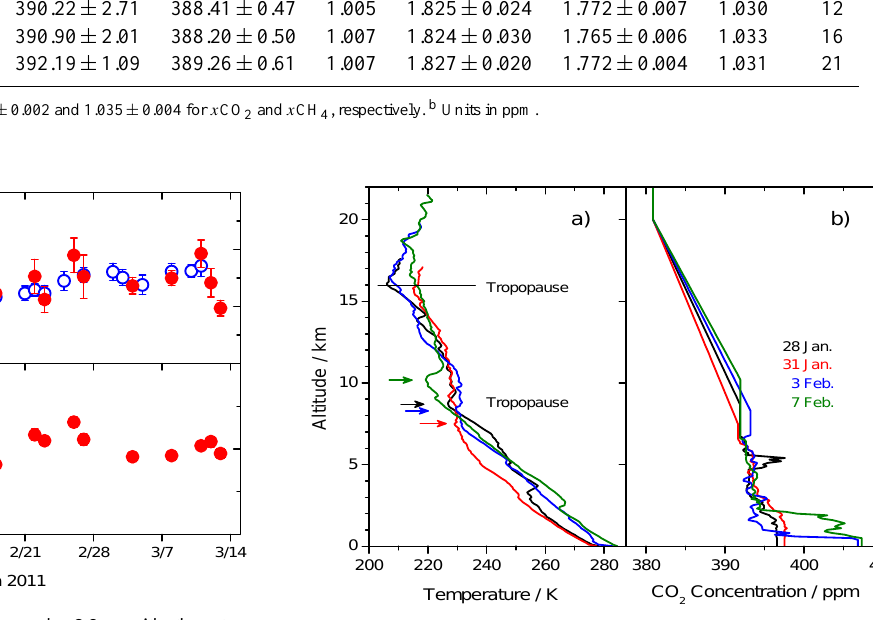
on 31 January and − 0.51 ppm on 8 March, respectively. The average x CO 2 from the OSA at UoW during 31 January– 13 March was 387.23 ± 1.57 ppm, being lower than that at JAXA in Tsukuba by 5.5 ppm. The vertical profiles of temperature over Tsukuba mea- sured by the sondes are shown in Fig. 7a where the first tropopauses lie at 8.7, 7.5, 8.3 and 10.2 km on 28 January (black), 31 January (red), 3 February (blue) and 7 Febru- ary (olive), respectively, indicated by arrows while a com- mon second tropopause exists around 16 km. Tropospheric CO 2 concentrations were measured in situ by means of the CME installed in the aircraft with a height profile ranging from about 400 m to 7 km in altitude. The vertical CO 2 pro- files over Tsukuba were depicted by a previously reported estimation (Araki et al., 2010): the CO 2 concentration at the lowest observable point was assumed to continue down to the surface while that at the highest point at about 7 km ex- tends up to the first tropopause (Fig. 7b). The CO 2 concen- tration at the first tropopause was assumed to decrease lin- early to the value at 20 km in altitude (Araki et al.,